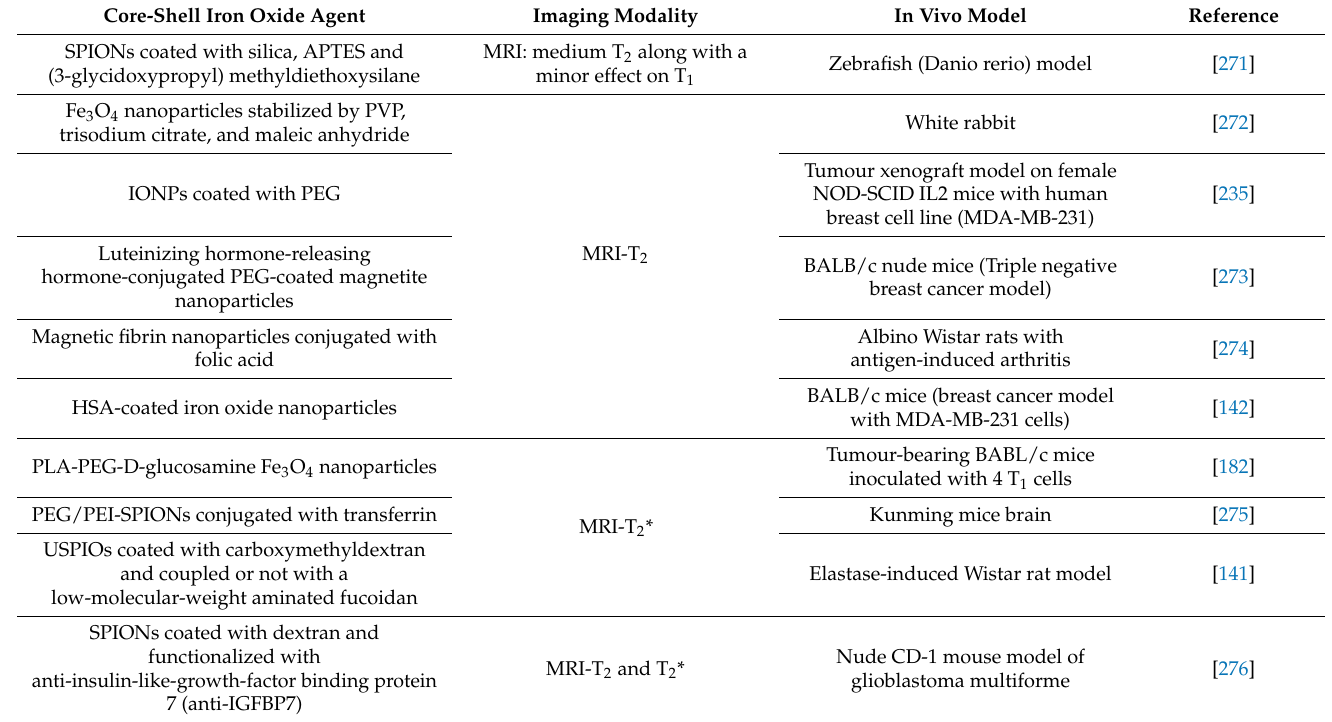
Table 6. Examples of animal studies assessing the use of iron oxide-based nanoparticles in imaging. Core-Shell Iron Oxide Agent